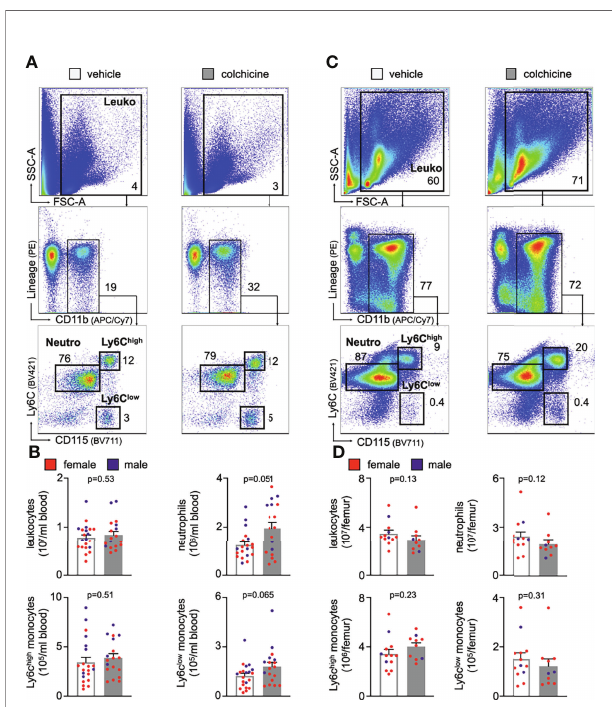
FIGURE 4 | Colchicine treatment did not alter numbers of blood leukocyte subsets. Flow cytometric gating and quanti fi cation of myeloid cells in the blood (A, B) ( n =18-21 per group, 62-67% female, Student ’ s t -test for total leukocytes (Leuko) and Ly6C high monocytes (Ly6C high ), Mann-Whitney U -test for neutrophils (Neutro) and Ly6C low monocytes (Ly6C low ) and bone marrow (C, D) in vehicle- vs. colchicine-treated Apoe -/- mice ( n =10-13 per group, 77- 80% female, Mann-Whitney U -test). Data are presented as mean+s.e.m. Numbers inside/next to gates indicate population frequencies (%). Dots within bar plots show the gender of the mice with a color code: purple (male) and red